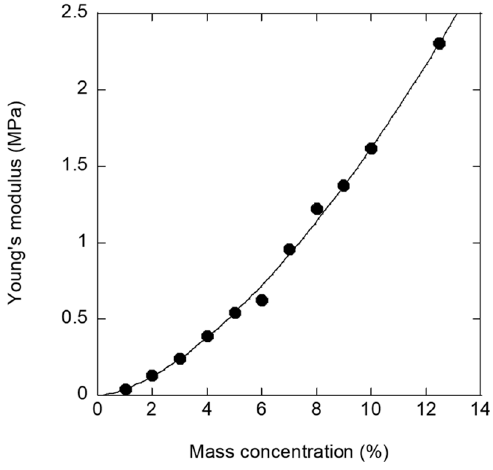
Figure 2. Young’s modulus dependence of mass concentration of agarose.